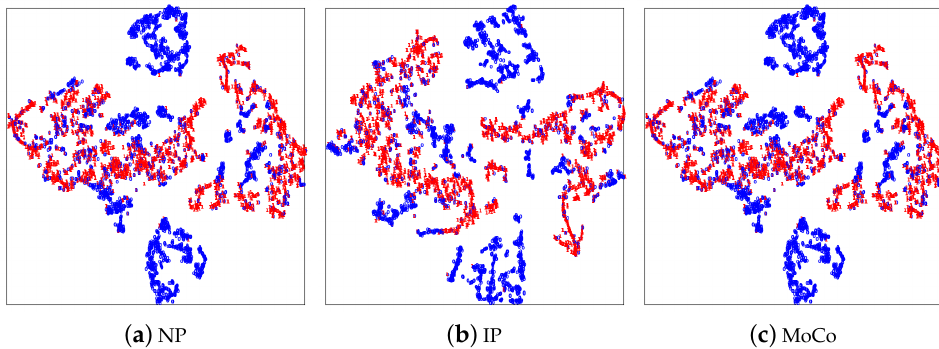
Figure 7. Visualization of positive and negative features extracted by BNN with NP, IP, and MoCo pre-training using t-SNE. The red dots represent the positive features, and the blue dots represent the negative